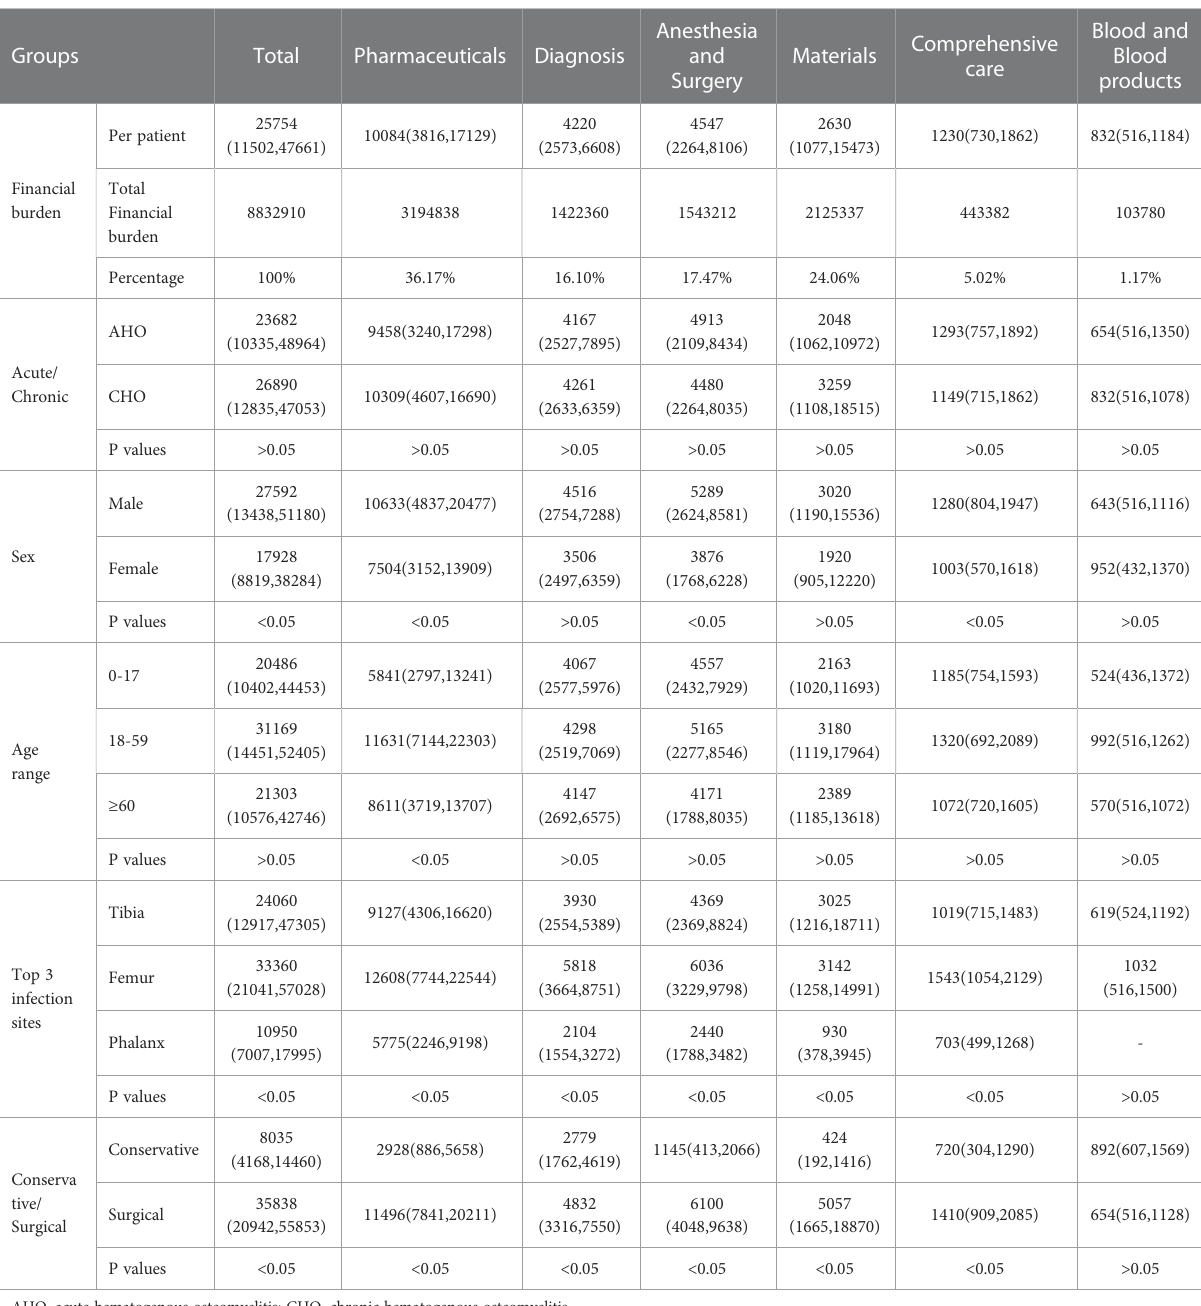
TABLE 7 Financial burden and fi nancial burden classi fi cation